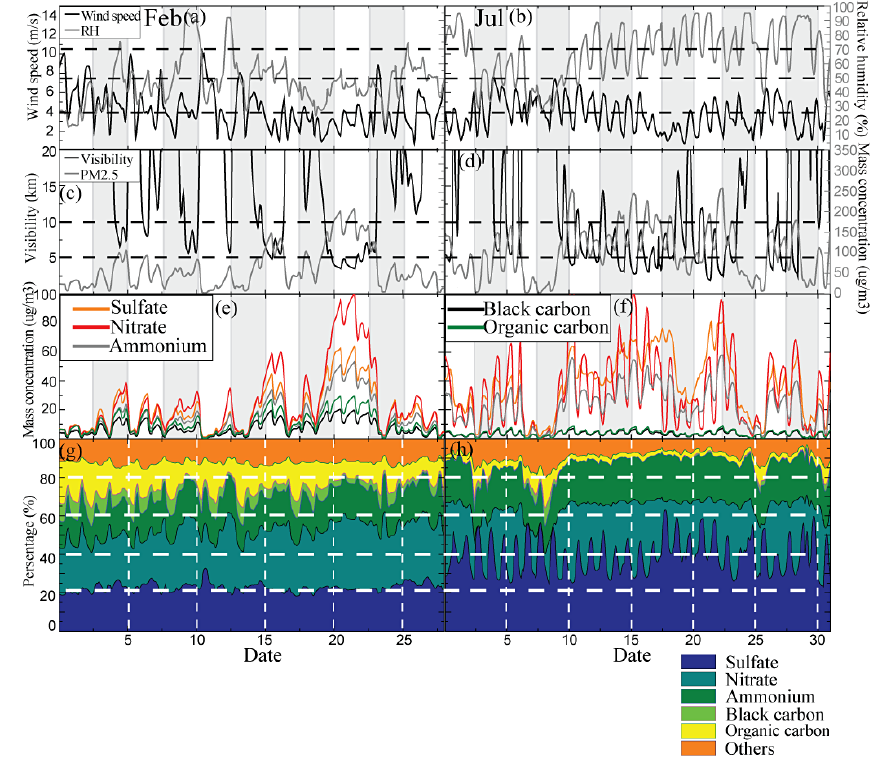
Figure 13. Time series of the regional-average surface wind speed (ms − 1 ), relative humidity (%), visibility (km), and PM 2 . 5 mass concen- trations (µgm − 3 ) in February and July in Beijing (a–d) . Also shown are the mass concentrations (µgm − 3 ; e–f ) and extinction contribution ratios (g–h) of sulfate, nitrate, ammonium, BC, OC, and other aerosols (dust, sea salt, and unspecified anthropogenic mass).